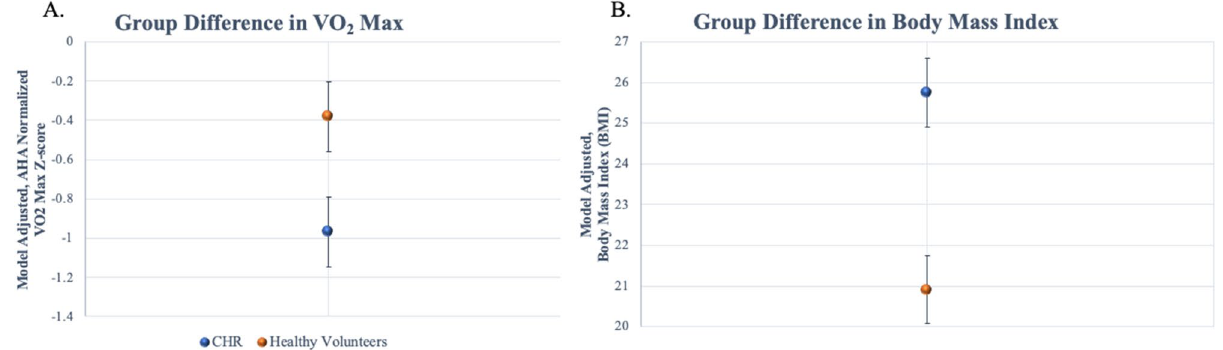
Figure 1. CHR physical markers of fitness and perceived fitness metrics: CHR group differences in VO 2 max (A) and body mass index (B)